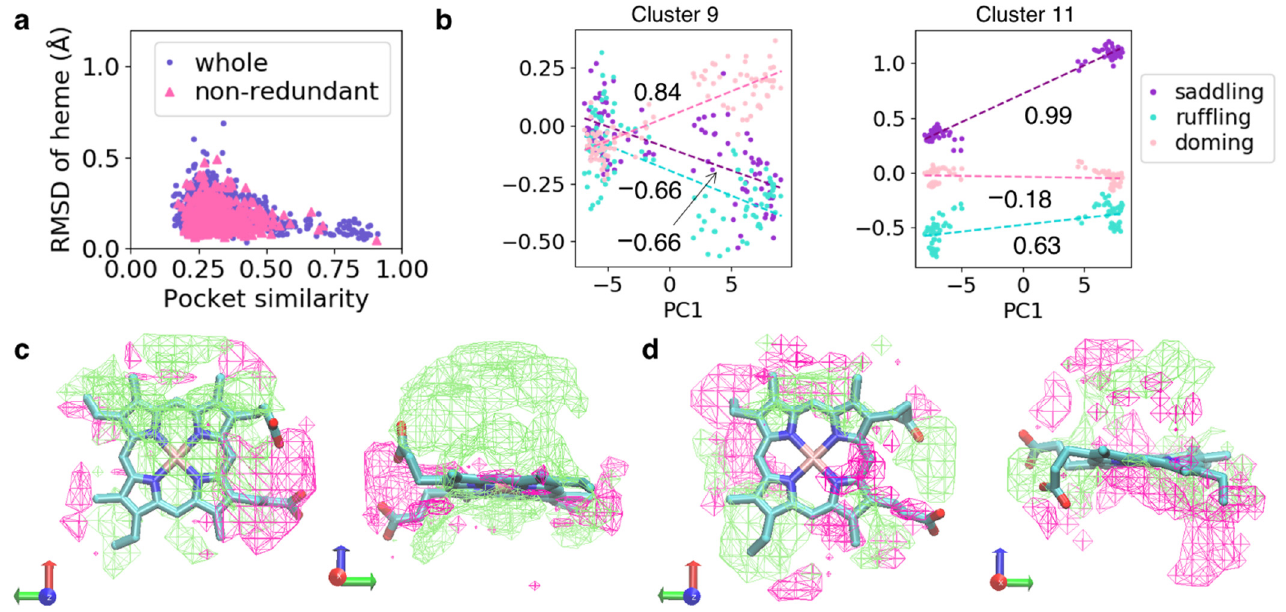
Figure 5. ( a ) Plot of similarity scores of cavity shapes versus RMSD of heme for the pairs of protein chains in the whole and non-redundant datasets. ( b ) Plot of PC1 values of cavity shapes versus the magnitude of distortion of heme in Clusters 9 (left panel) and 11 (right panel). Dashed lines colored in the dark-orchid, pink, and turquoise are linear regression lines for saddling, ruffling, and doming distortions, respectively. Values in the graph are correlation coefficients calculated from linear re- gression analysis. ( c , d ) First eigenvectors obtained from PCA for Clusters 9 ( c ) and 11 ( d ). Lime and magenta mesh surfaces represent the isosurfaces of +0.25 and − 0.25. Structures with large PC1 values would have the cavity containing lime area but not the magenta area. Heme is represented as the licorice model. Left and right panels show the same vector viewed from different directions.